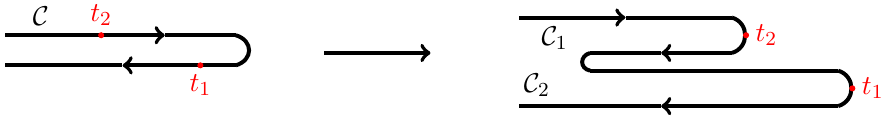
Figure 2. Contour deformation for Langreth